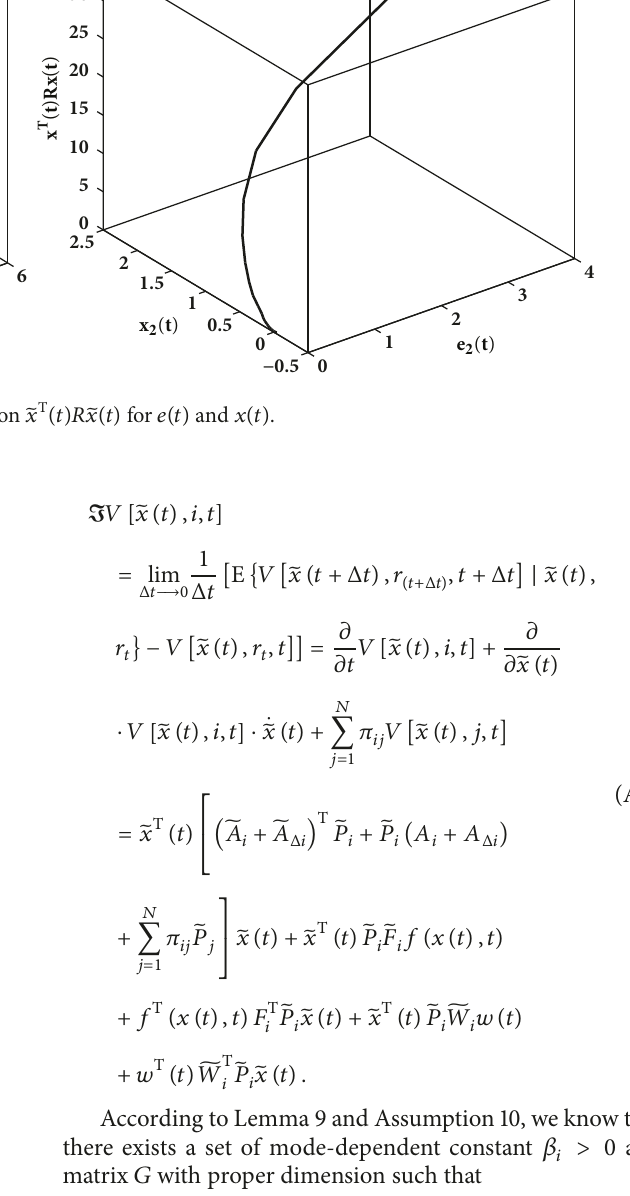
disturbance attenuation index. A numerical example was delivered to demonstrate the contribution of the main